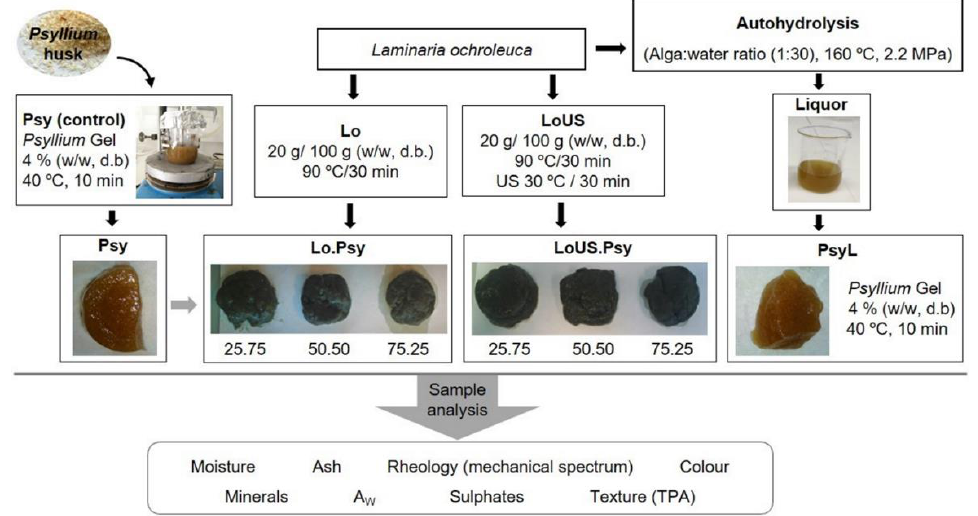
Figure 1. General schematic procedure of the gel preparation and analysis (Lo— Laminaria ochroleuca ; Psy— Psyllium gel prepared with water (control); US—ultrasound treatment; PsyL— Psyllium gel prepared with autohydrolysis liquor).